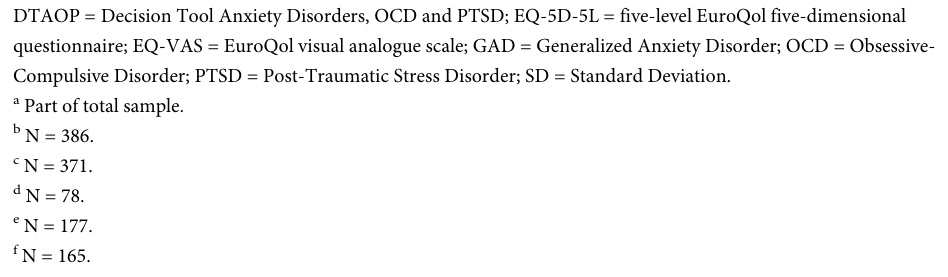
Validity. Consistent with our hypotheses, the DTAOP negatively correlated with the EQ- and Table 5 for the operating characteristics of the DTAOP at various cut-off scores. The area under the curve (AUC) was 0.826 (95% CI, 0.772–0.881; P < 0.001) and the Youden index was highest at a cut-off score of � 4 (J = 0.471), with a sensitivity of 0.700 (95% CI, 0.610–0.780) and a specificity of 0.771 (95%, CI 0.674–0.850). Continued development of the DTAOP. Based on the qualitative feedback (feasibility results) and reliability estimates, consortium members proposed revisions to the wording and instructions of items 2 to 6. To improve the distinctiveness and item clarity of item 2 ("Socio- demographic or personal factors maintaining the anxiety disorder, OCD or PTSD") and 4 ("Treatment-interfering psychosocial factors and/or compensating individual characteristics"), the item wording and instructions of both items were revised. Additionally, cut-off scores by which the presence or absence of treatment-interfering psychosocial dysfunctioning (item 3)